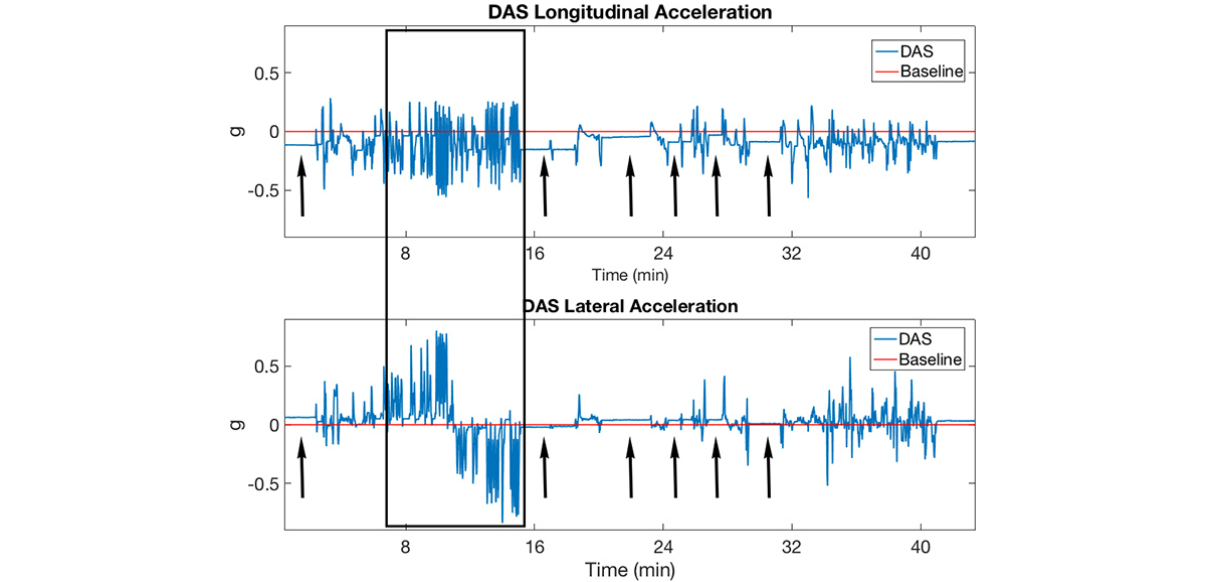
Figure 6. The effects of in-vehicle weight distribution on baseline acceleration measurements. The acceleration measurements offset from the baseline varied (arrows) based on the number of passengers/weight distribution inside the vehicle. Comparison with the Android and iPhone devices within the black box is show in Figure 7. DAS: data acquisition system.